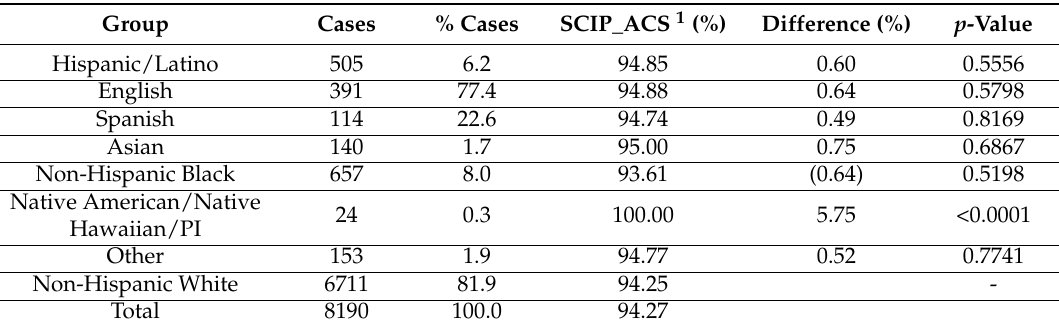
Table 4. Baseline Data Surgical Care